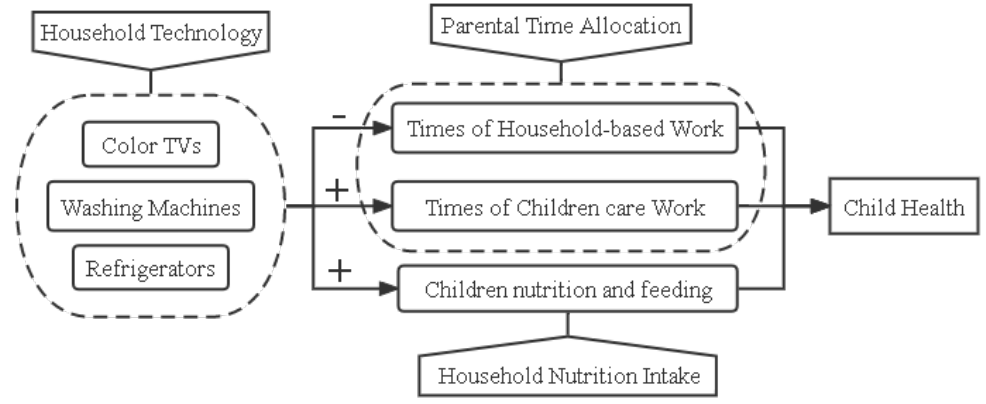
Figure 2. How household technology affects child health.